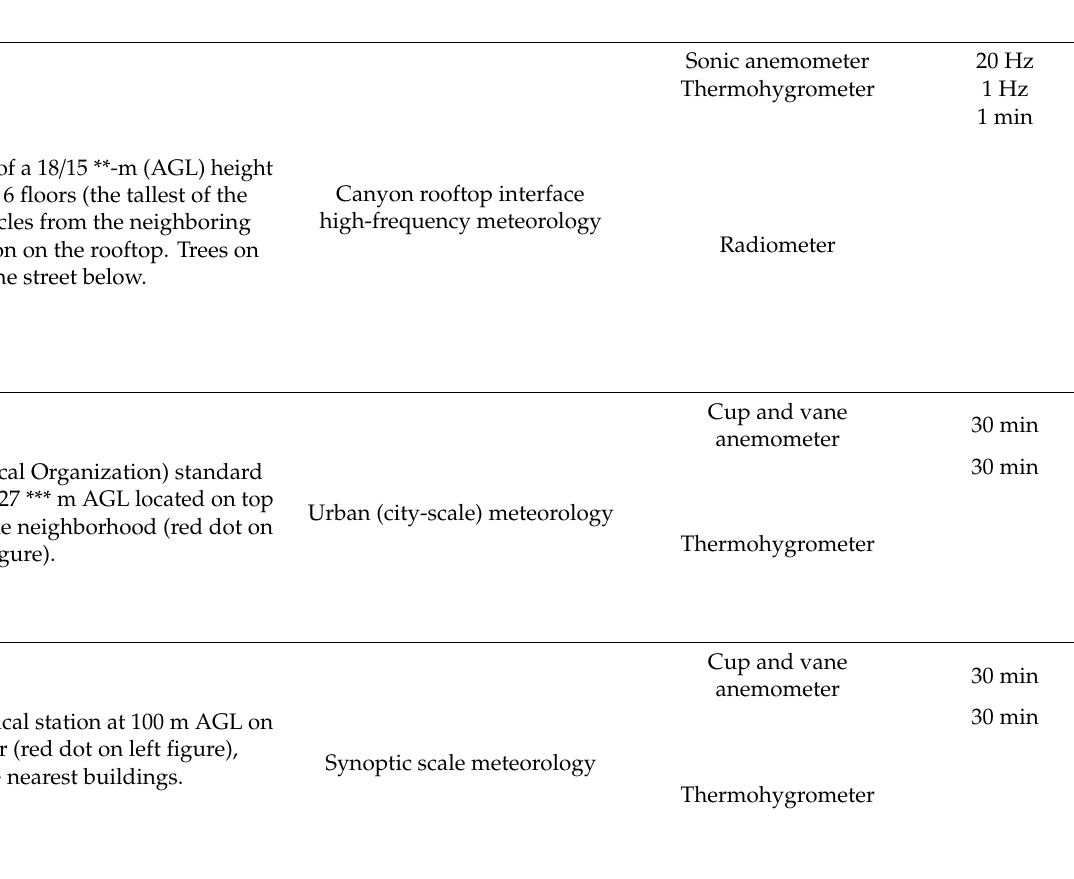
WMO-(World Meteorological Organization) standard meteorological station at 35 / 27 *** m AGL located on top of the highest building of the neighborhood (red dot on left figure). neighborhood (red dot on left figure).